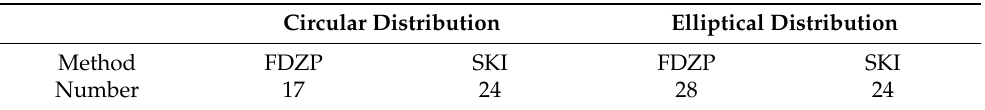
Table 1. The minimum NARA required by FDZP method and skeletonization-based method when the interpolation error was less than